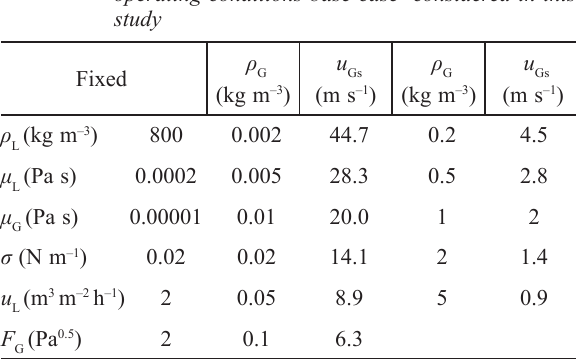
Table 1 – Fixed and variable parameters of the hypothetical operating conditions base case 1 considered in this study